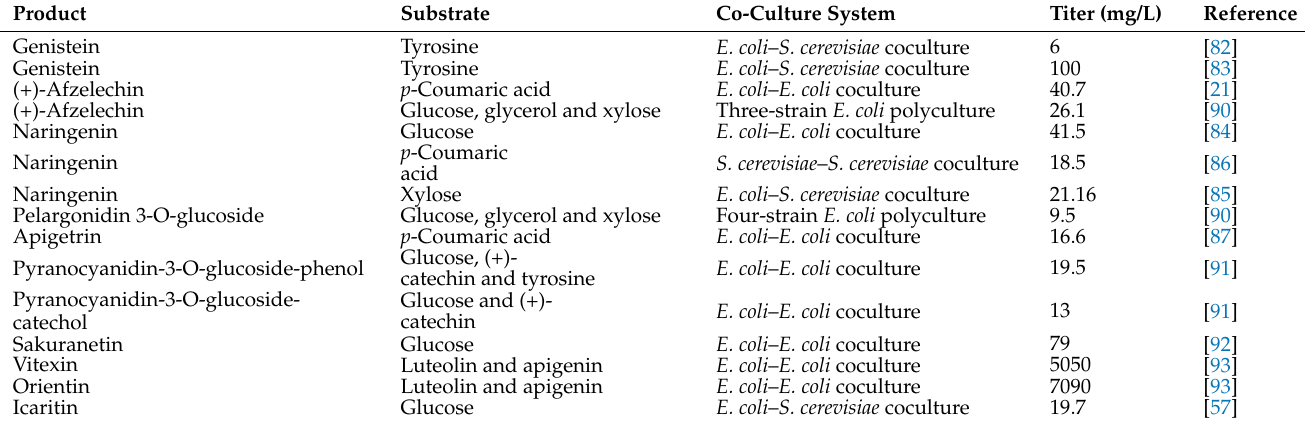
Table 3. Recent examples of modular co-culture engineering for flavonoids